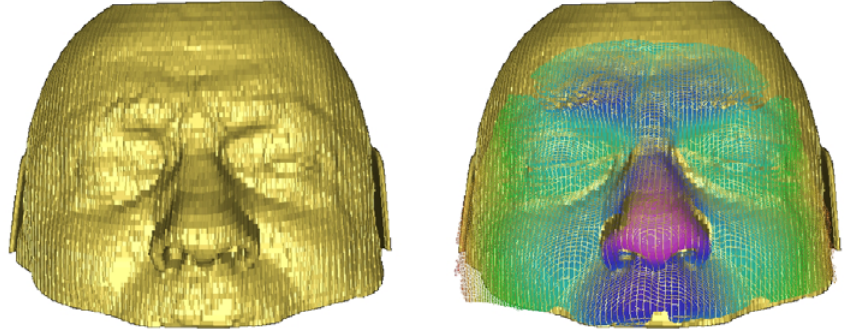
Fig. 3 Surface reconstruction of facial soft tissue from CT data (left), with laser surface scan superimposed